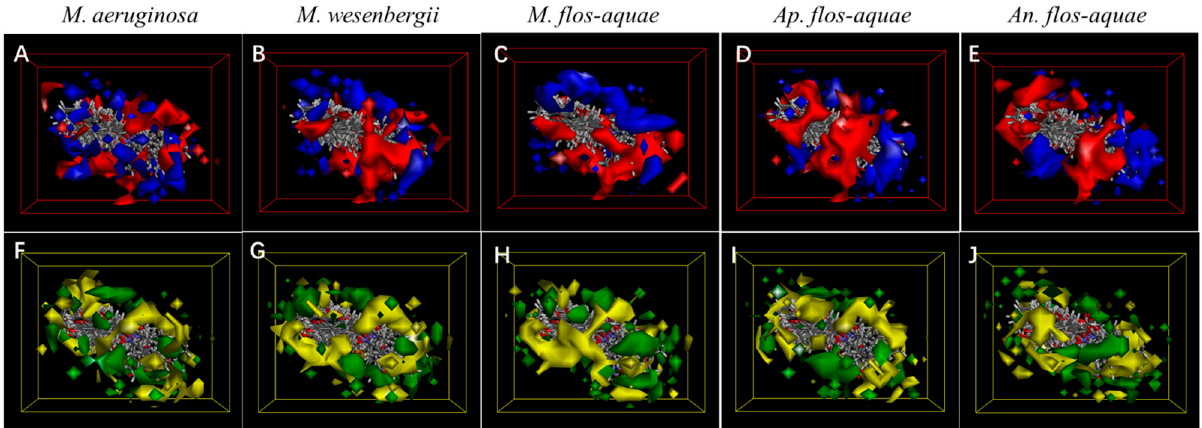
Figure 3. ( A – E ) 3D-QSAR model coefficients on electrostatic potential grids. Blue represents positive coefficients, and red represents negative coefficients. ( F – J ) 3D-QSAR model coefficients on van der Waals grids. Green represents positive coefficients, and yellow represents negative coefficients.